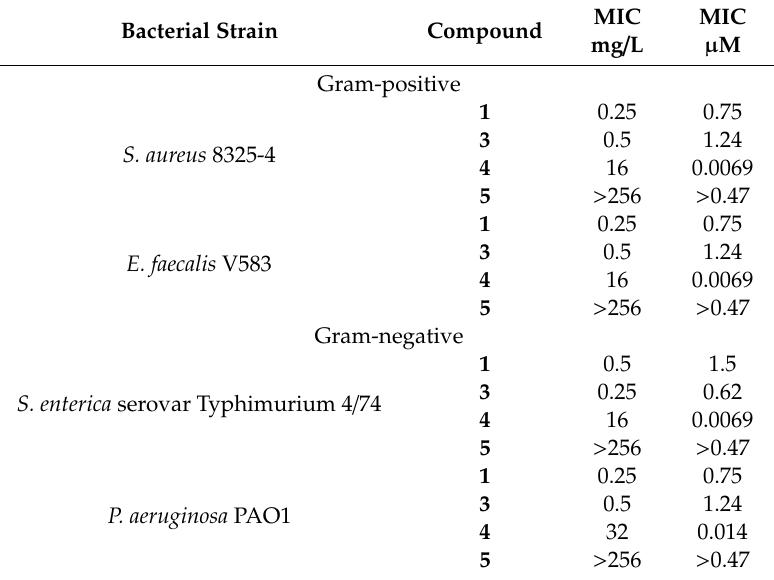
Table 1. MIC-values of the compounds tested in four di ff erent strains of pathogenic bacteria. The MIC-values are the median of three biological replicates.